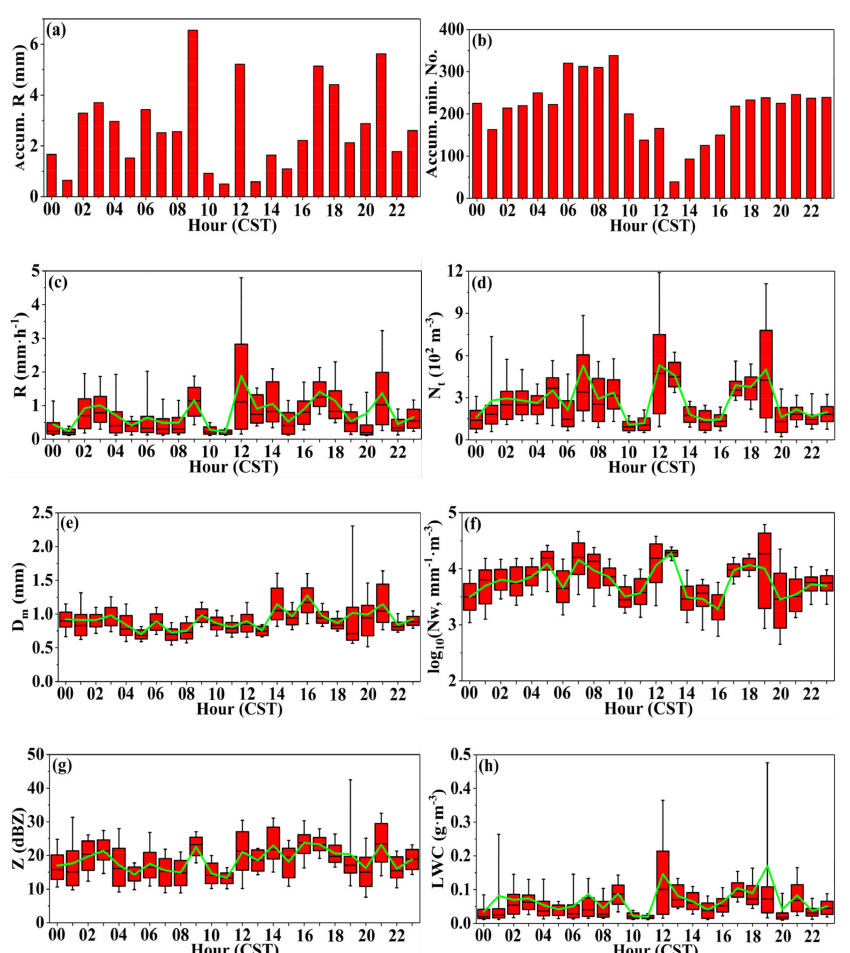
Figure 4. Diurnal variations in ( a ) accumulated rain amount, ( b ) accumulated rainy minute number, ( c ) precipitation intensity ( R ) (mm · h − 1 ), ( d ) number concentration of total raindrops ( N t ) (m − 3 ), ( e ) mass-weighted mean diameter ( D m ) (mm), ( f ) normalized intercept parameter ( N w ) (mm − 1 · m − 3 ), ( g ) radar reflectivity ( Z ) (dBZ), and ( h ) liquid water content ( LWC ) (g · m − 3 ) during the observation period. The green line represents the average, on each box, the central crossbar indicates the median, and the bottom and top edges of the box indicate the 25th and 75th percentiles, respectively. The black whiskers extend to the maximum and minimum of the data points,